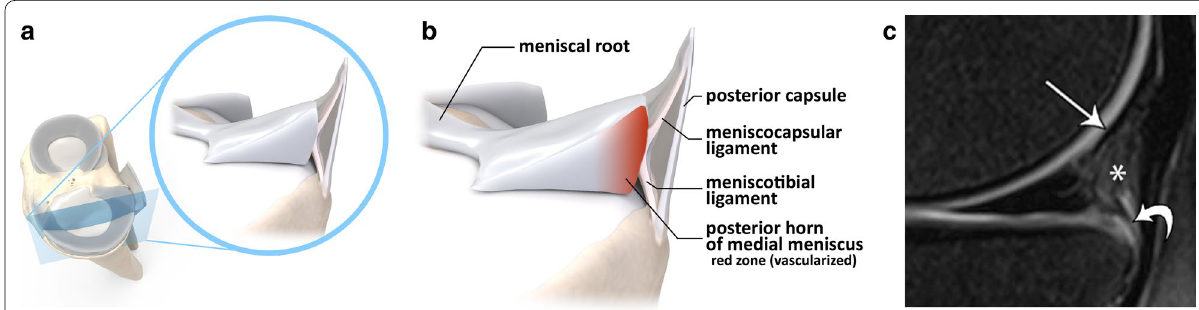
Fig. 1 Posterior medial meniscus anatomy, with its corresponding structures. In ( a ), an illustrated open view of the medial compartment of the knee, in ( b ), a zoomed view of the posteromedial capsular‑meniscal unit, and in ( c ), the corresponding MRI appearance on sagittal PD‑weighted fat suppressed: meniscocapsular ligament (thin arrow), meniscotibial ligament (curved arrow) and posterior capsular attachment (star)